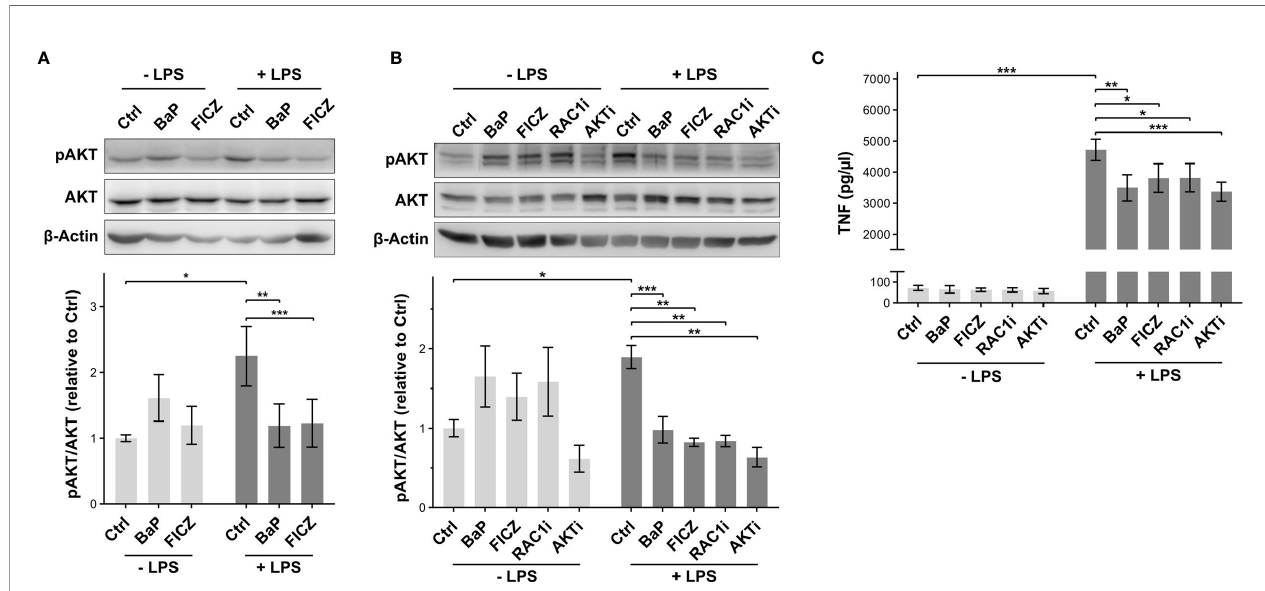
FIGURE 6 | Effect of AhR activation on AKT phosphorylation. (A) Relative AKT phosphorylation levels at serine 473 (pAKT) were determined by western blot analysis 2h after stimulation. The pAKT signal intensities were normalized to total AKT levels. Shown is one representative blot and normalized intensities relative to LPS- treatment ± SEM (n = 7). Macrophages were additionally pretreated for 30min with the RAC1 inhibitor NSC23766 (RAC1i) and the AKT inhibitor Perifonsine (AKTi) before 2h incubation in the absence and presence of LPS. The relative levels of pAKT (B) and TNF-secretion (C) were measured by western blot and ELISA, respectively (n = 5). Signi fi cant changes were determined by two-sided, paired t-test (***p ≤ 0.001, **p ≤ 0.01, *p ≤